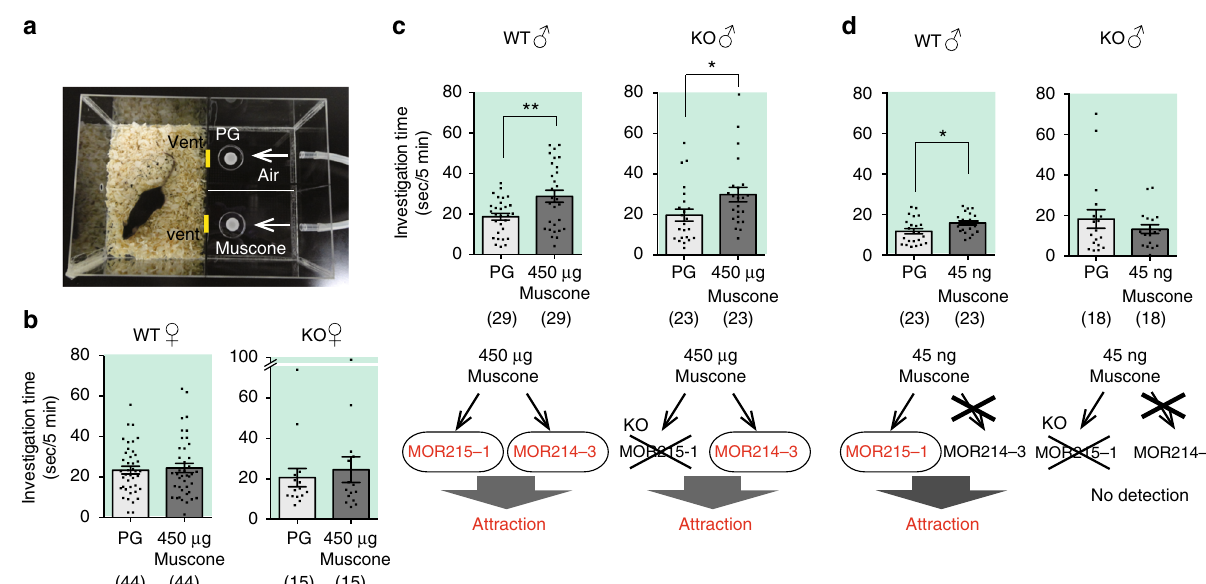
Fig. 1 Attraction to muscone via MOR215 – 1 and MOR214 – 3 in male mice. a Setup for the two-choice preference test. An individual test mouse is introduced into the room, and can poke its nose into either of two holes, from which muscone-containing air or control air (PG; propylene glycol) is constantly supplied. The total time spent the mouse spent nose-poking each vent hole was measured. b Investigation time for muscone (450 μ g) in wild type or MOR215 – 1 knockout female mice: PG (propylene glycol) vs. 450 μ g muscone dissolved in PG in C57BL/6 adult female mice (WT) ( N = 44) and MOR215 – 1 knockout adult female mice (KO) ( N = 15). c Investigation time for muscone (450 μ g) in wild type or MOR215 – 1 knockout male mice. (top) PG vs. 450 μ g muscone in PG in C57BL/6 adult male mice (WT) ( N = 29) and MOR215 – 1-KO adult male mice (KO) ( N = 23). (bottom) A possible model showing the involvement of two muscone ORs in attraction to 450 μ g muscone. d Investigation time for muscone (45 ng) in wild type or MOR215 – 1 knockout male mice. (top) PG and MOR215 – 1-KO adult male mice (KO) ( N = 18). (bottom) A possible model showing how 45 ng muscone activates only MOR215 – 1, leading to attraction. Bars indicate the mean time that a mouse spent investigating each test sample within a 3-min period, ±S.E.M. Asterisks indicate signi fi cant differences between two samples (paired Student ’ s t -test, * P < 0.05, ** P <